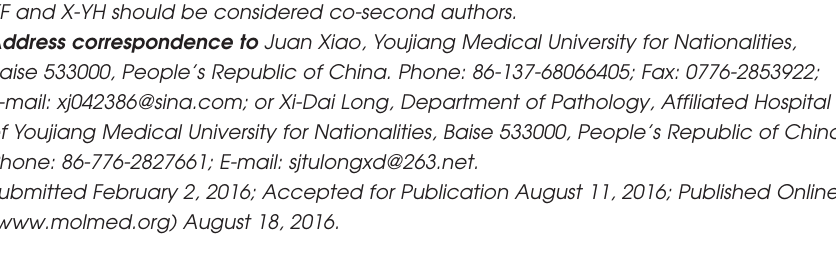
digestive zymogens, which